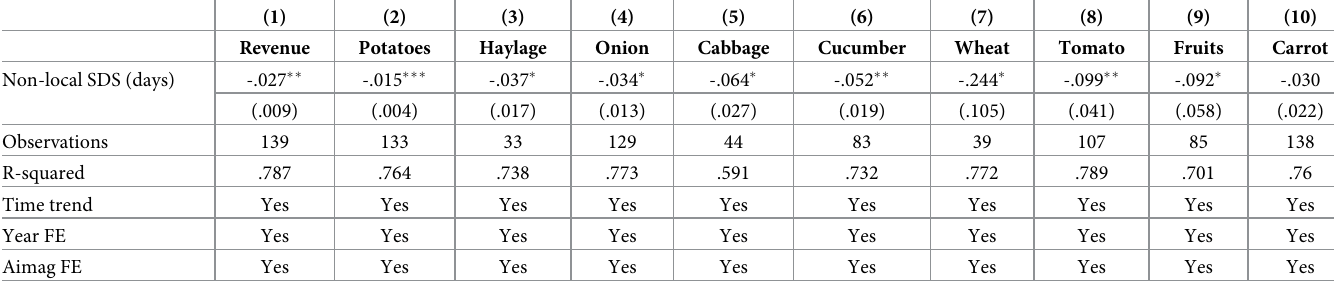
Table 4. Impact of SDS on revenues and production based on alternative estimation (corrected for